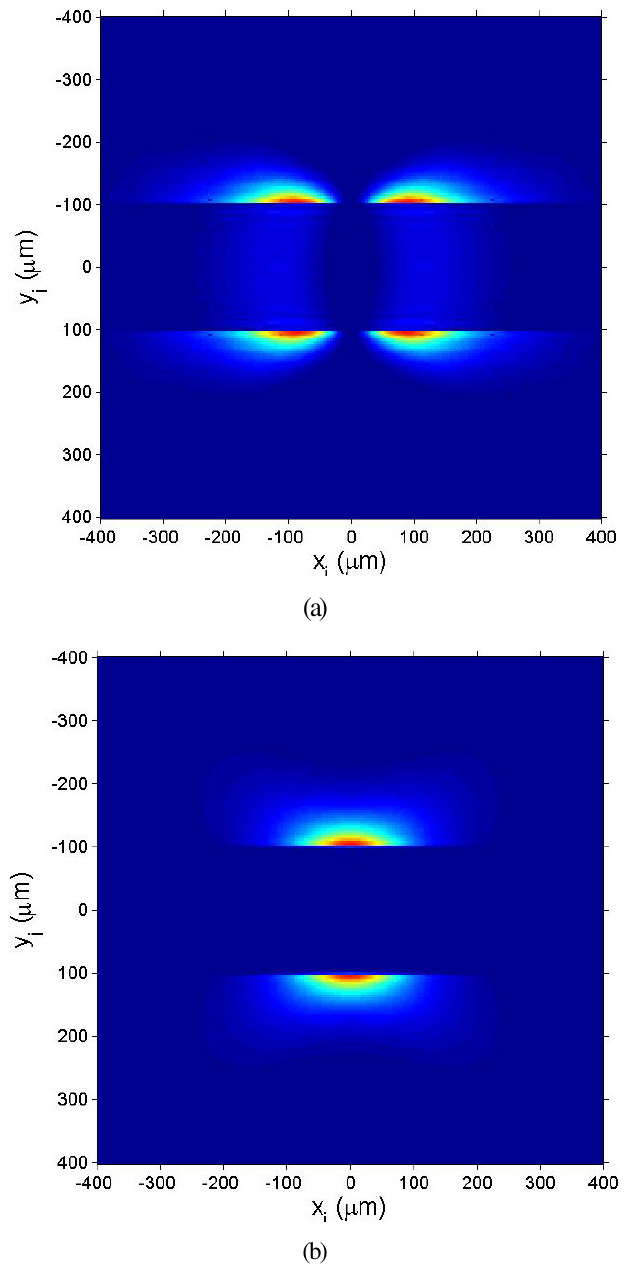
FIG. 6. (Color) PSF of the ODR from rectangular slit with horizontal component (a) and with vertical component